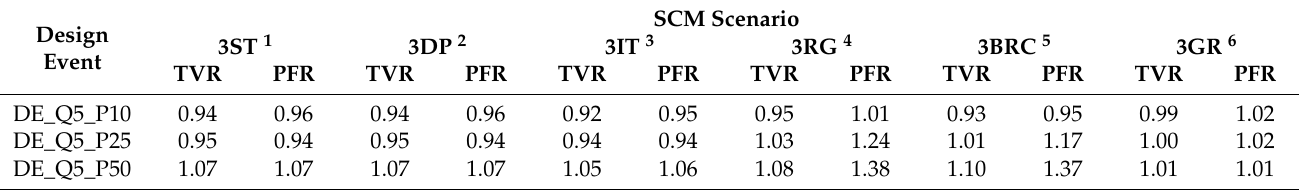
Table 7. The performance of stormwater control measure (SCM) scenarios for the analyzed design events, evaluated with the total volume ratio (TVR) and peak flow ratio